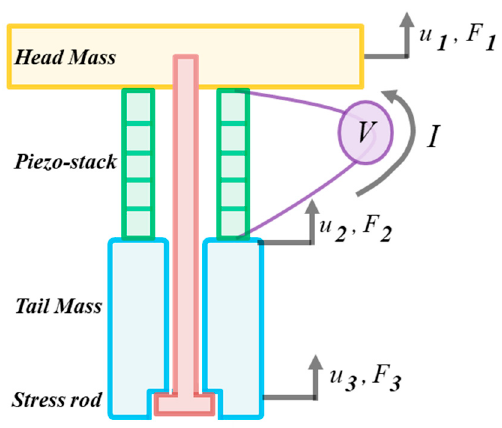
Figure 1. Free body diagram of a tonpilz transducer.